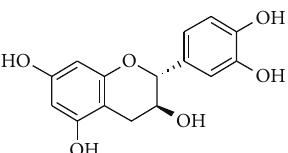
Figure 1: Structural image of (+)-catechin